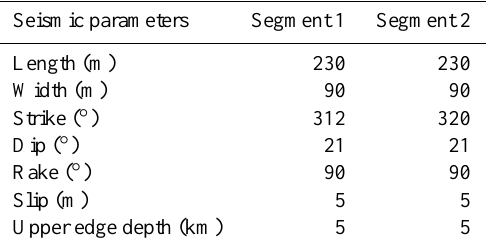
Table 2. Seismic parameters of AD 365 Crete earthquake, as recon- structed by Tonini et al. (2011), for the north (segment 1) and south (segment 2).